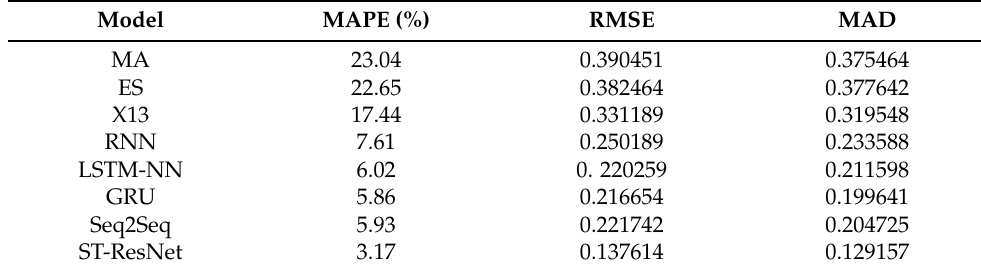
Table 4. Comparison of medium-term forecasting results.